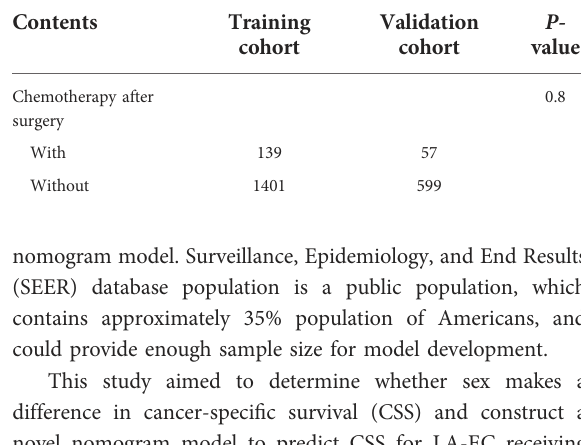
TABLE 1 Comparisons of baseline characteristics between training cohort and validation